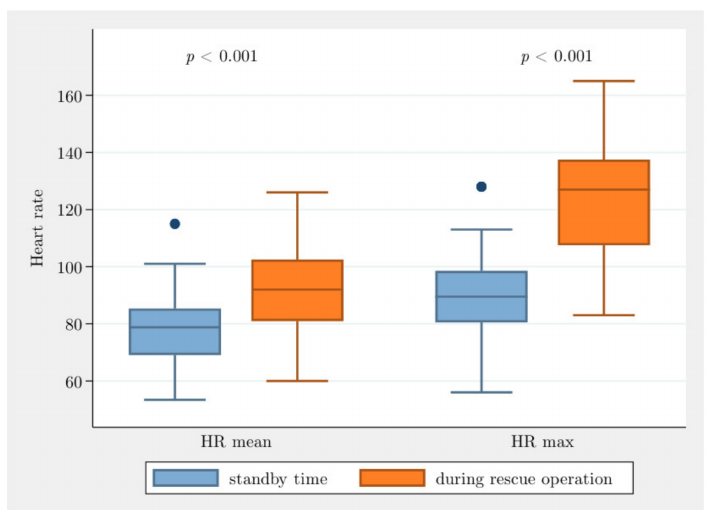
Figure 2. Overview of mean (HR mean) and maximum (HR max) heart rates during standby time and rescue